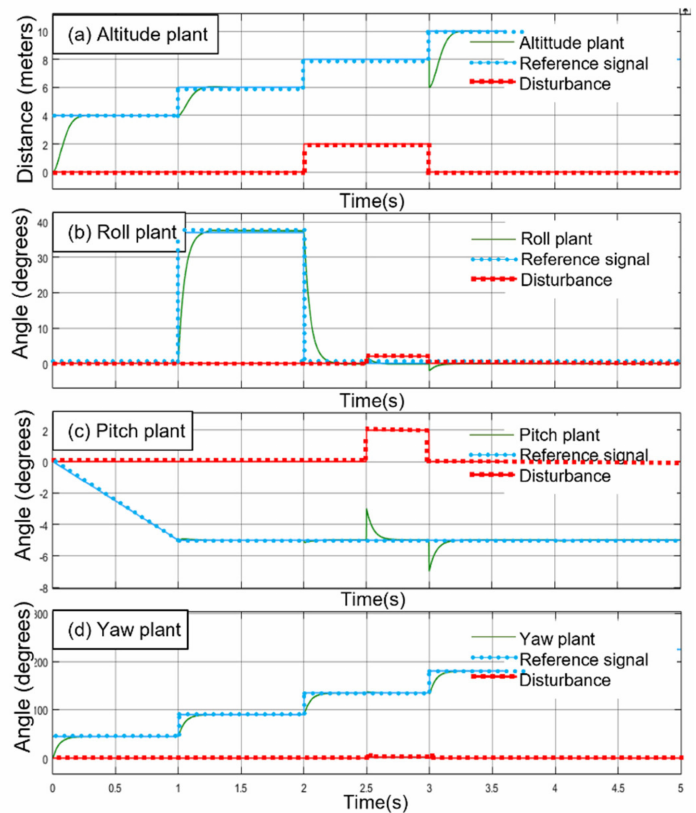
Figure 15. Mamdani Fuzzy–PD simulation results. ( a ) Altitude plant, ( b ) roll plant, ( c ) pitch plant, ( d ) yaw plant.